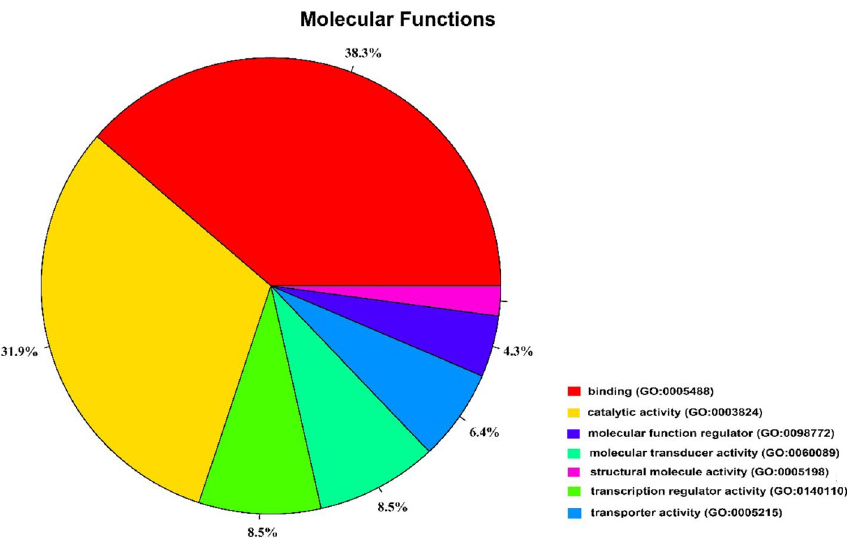
Figure 2. The pie chart of molecular functions attributed to candidate genes detected by overlapping selective signals of Z(F ST ) and log 2 (θ π ratios